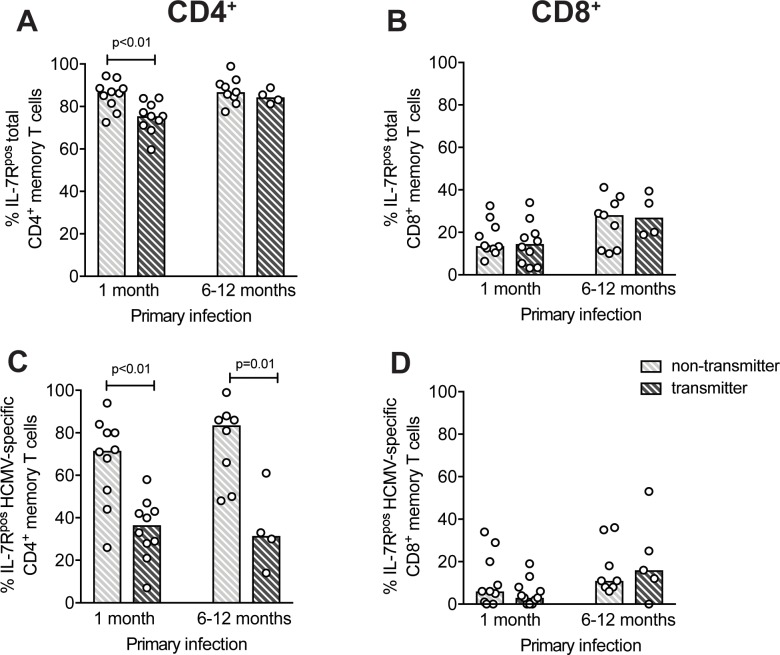
Pregnant women non-transmitting HCMV to the fetus have higher frequencies of long-term IL-7Rpos memory CD4+ T cells than transmitting women.Percentages of IL-7Rpos T cells among (A, B) total memory or (C, D) HCMV-specific CD4+ or CD8+ T cells in pregnant women transmitting or non-transmitting the infection to the fetus (n = 11 and n = 10, respectively) analyzed 1 month or 6–12 months (n = 8 and n = 4, respectively) after primary infection are reported. “HCMV-specific” indicates the sum of the single protein-specific T cells. Each symbol represents an individual and column upper limits indicate median values. P values were determined by Mann-Whitney U test.